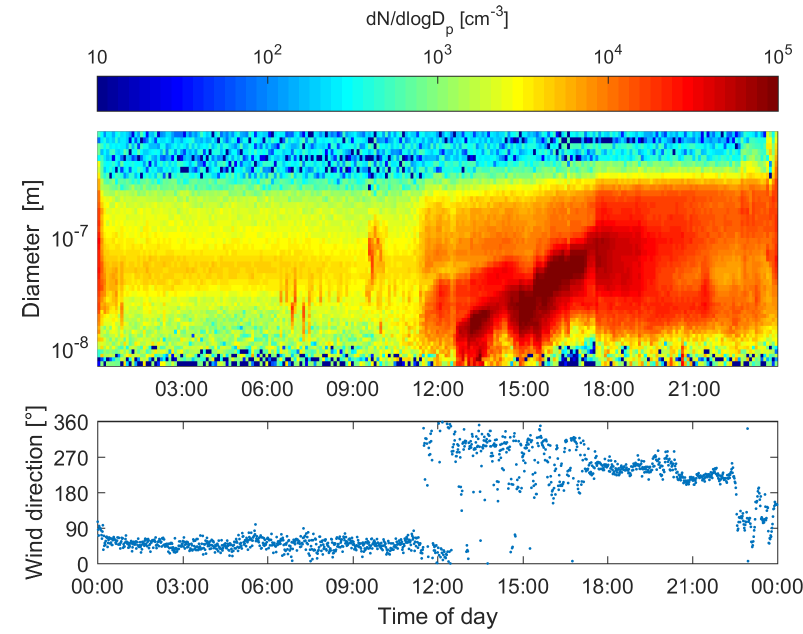
Figure A3. An example illustrating a case where the late starting time of an NPF event is related to a delayed shift in the wind direction in Hada Al Sham, 5 February 2013.